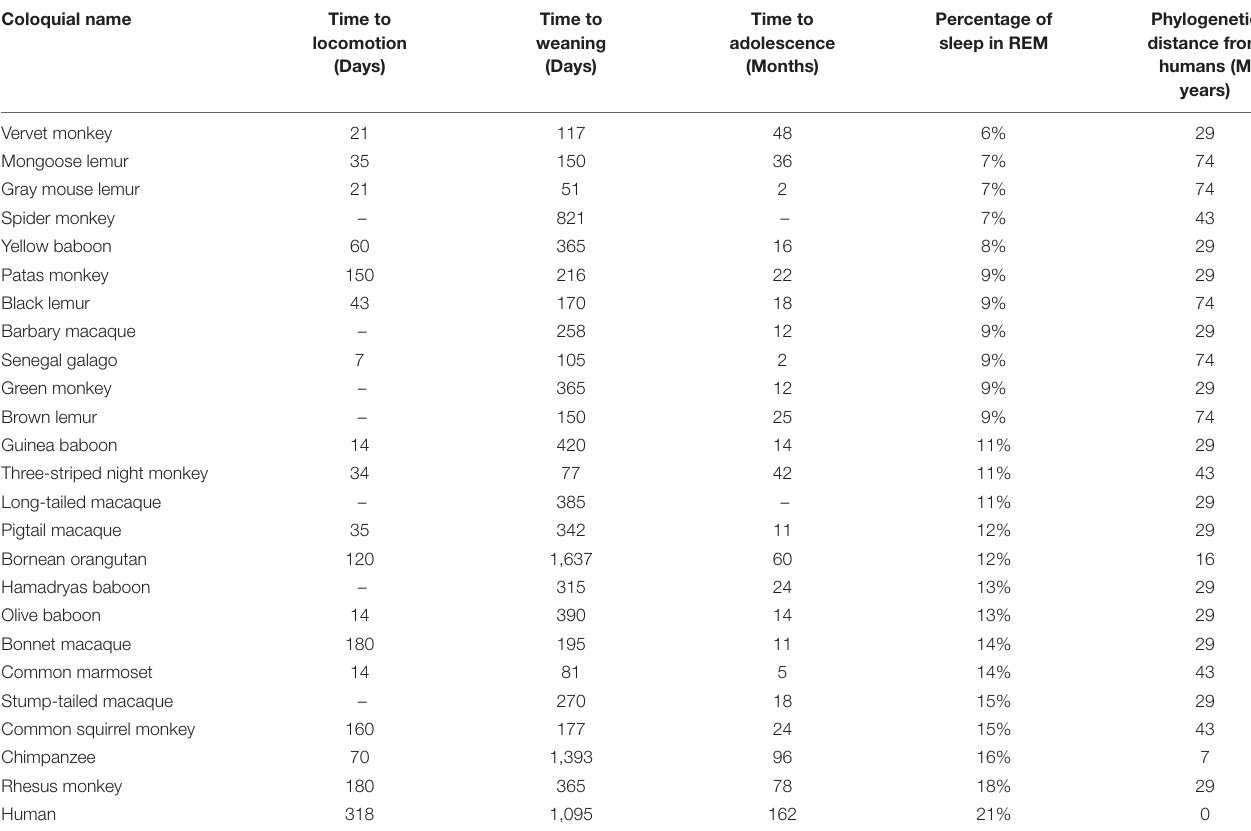
TABLE 1 | Three behavioral correlates of plasticity and the proportion of REM (versus non-REM) sleep in 25 primate species. Coloquial name Time to